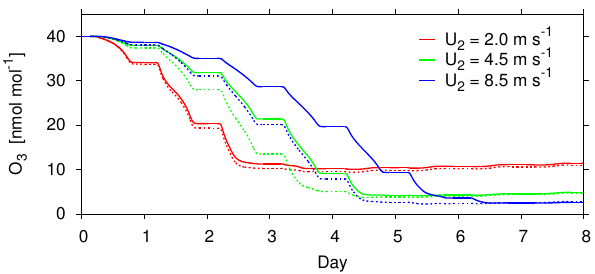
Fig. 10. Simulated sensitivity of the timescale of ozone depletion in the air (at the height of 1.5m) at U 2 = 2.0ms − 1 (red lines), 4.5ms − 1 (green lines) and 8.5ms − 1 (blue lines) on the initial con- centration of Br − in the top 1mm of snowpack. Solid lines denote results from our baseline scenario with initial Br − /Cl − molar ratio at 1/650 in the entire snowpack, whereas dotted lines denote results from sensitivity runs in which initial Br − concentration in the snow- pack is raised by a factor of 10 between 0–1mm in depth (i.e., top two layers in the model